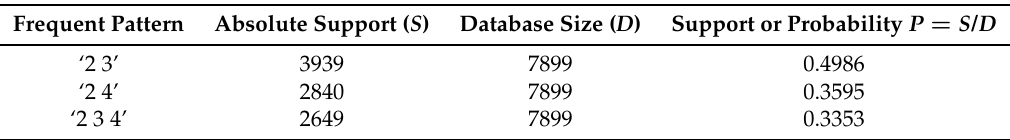
Table 4. Frequent patterns: frequent patterns discovered